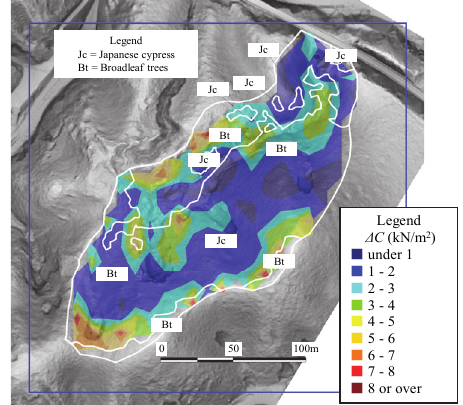
Legend Tree diameter at breast height